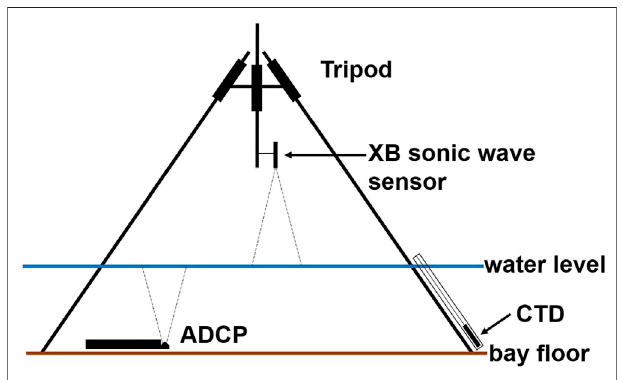
FIGURE 2 | The con fi guration of the sensor tripods and how the XB, ADCP, and CTD sensors were arranged.